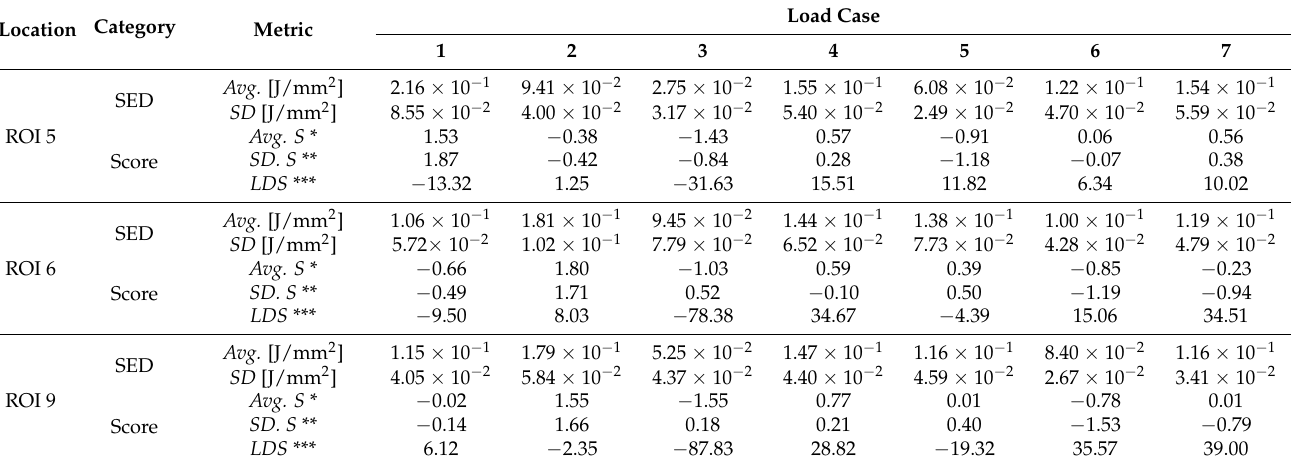
Table 4. Result of statistical analysis for strain energy density and scores for ROIs in the metaphysis for each load